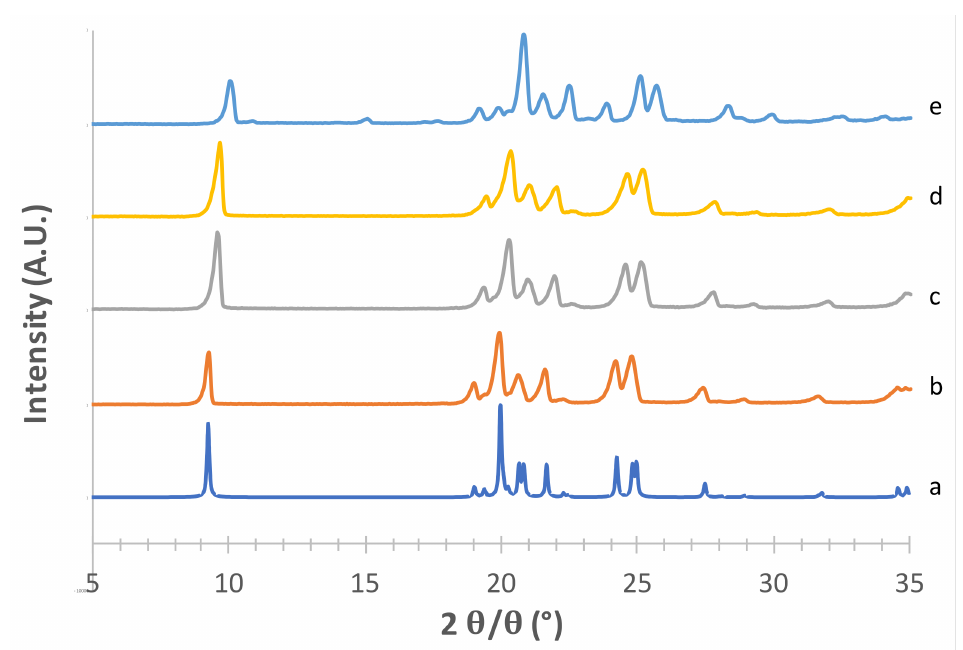
Figure 7. PXRD patterns of mannitol δ form recorded at (b) time zero; (c) 1 month; (d) 12 months; (e) 24 months storage at 40 ◦ C and 75% R.H. (a) CCDC 224660 as reference. XRPD analyses were performed to evidence possible solid-phase